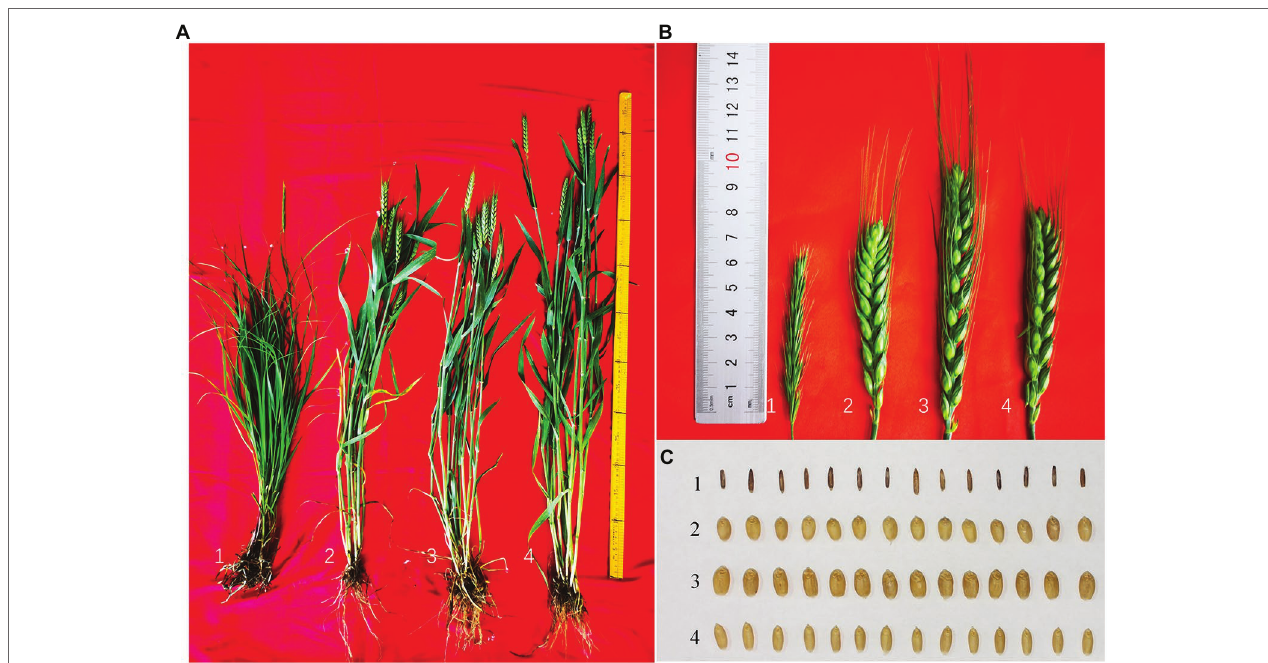
FIGURE 6 | Plant morphology of wheat– P. huashanica translocation line E24-3-1-6-2-1 and its parents. (A) Adult plant, (B) spikes, and (C) kernels. Numbers 1–4 represent P. huashanica , 7182, line E24-3-1-6-2-1, and line 24-6-3-1, respectively.